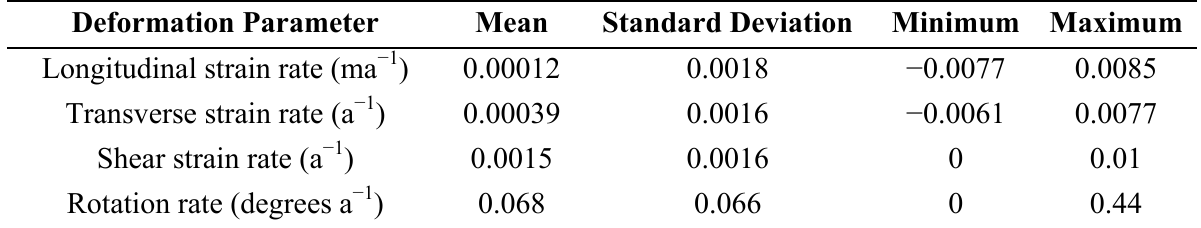
Table 5. Summary statistics of the computed deformation parameters of the Muragl